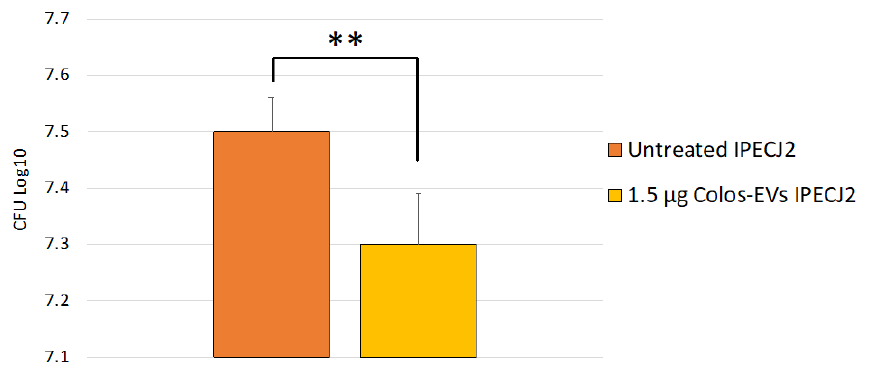
Figure 4. Adhesion of E. coli strains on 1.5 μg colosEVs pre-treated cells compared with untreated ones. Data are expressed as log10 CFU of adherent, E. coli /5 × 10 5 cells and mean value of 3 experiments ± 1 standard deviation. Differences were evaluated through the Student’s t -test. The asterisks indicate the statistical significance: ** p < 0.01.